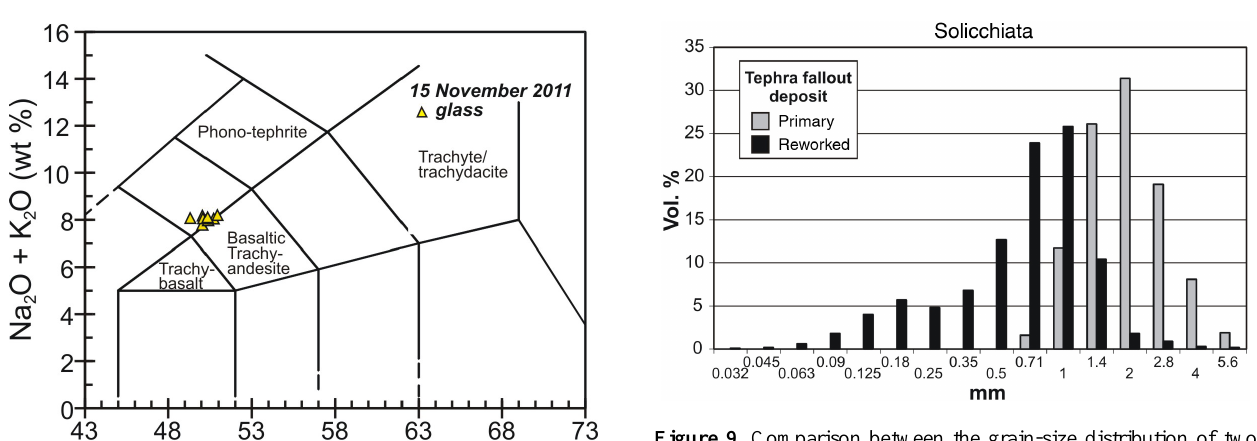
Figure 9. Comparison between the grain-size distribution of two samples collected at the same site in Solicchiata village (14km northeast of the vent): primary (grey) and reworked (black) tephra fallout deposit after grinding by passing